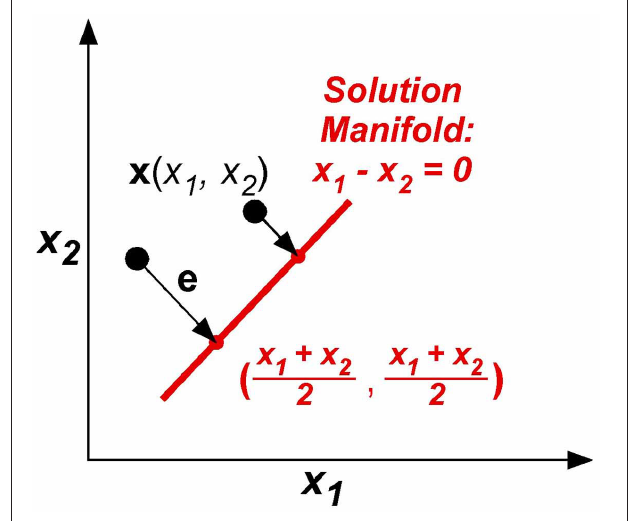
FIGURE 7 | The model task: two execution variables ( x 1 , x 2 ) and one result variable e are defined in execution space. Error e is defined by minimum distance between x and x Target in execution